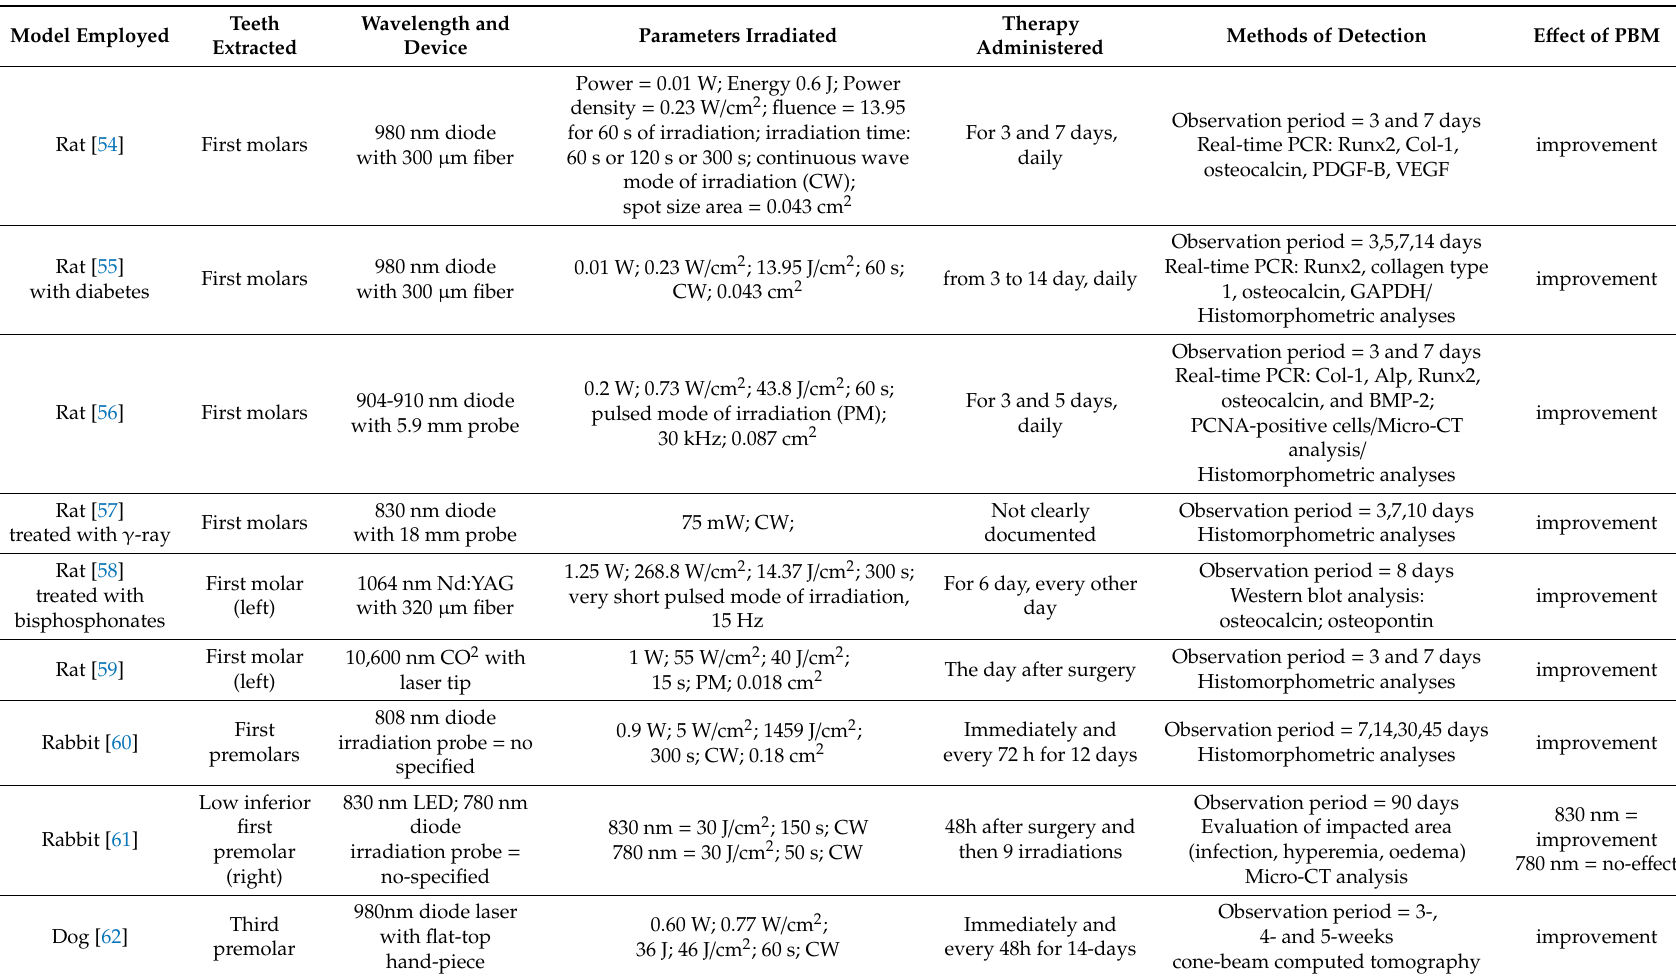
Table 1. Study on photobiomodulation (PBM) and socket preservation in animal models. A schematic representation of the experimental set-up and